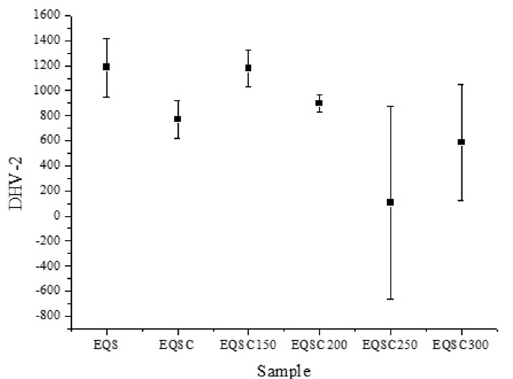
Figure 6. Dynamic plastic hardness (DHV-2) for the different kinds of samples studied in this